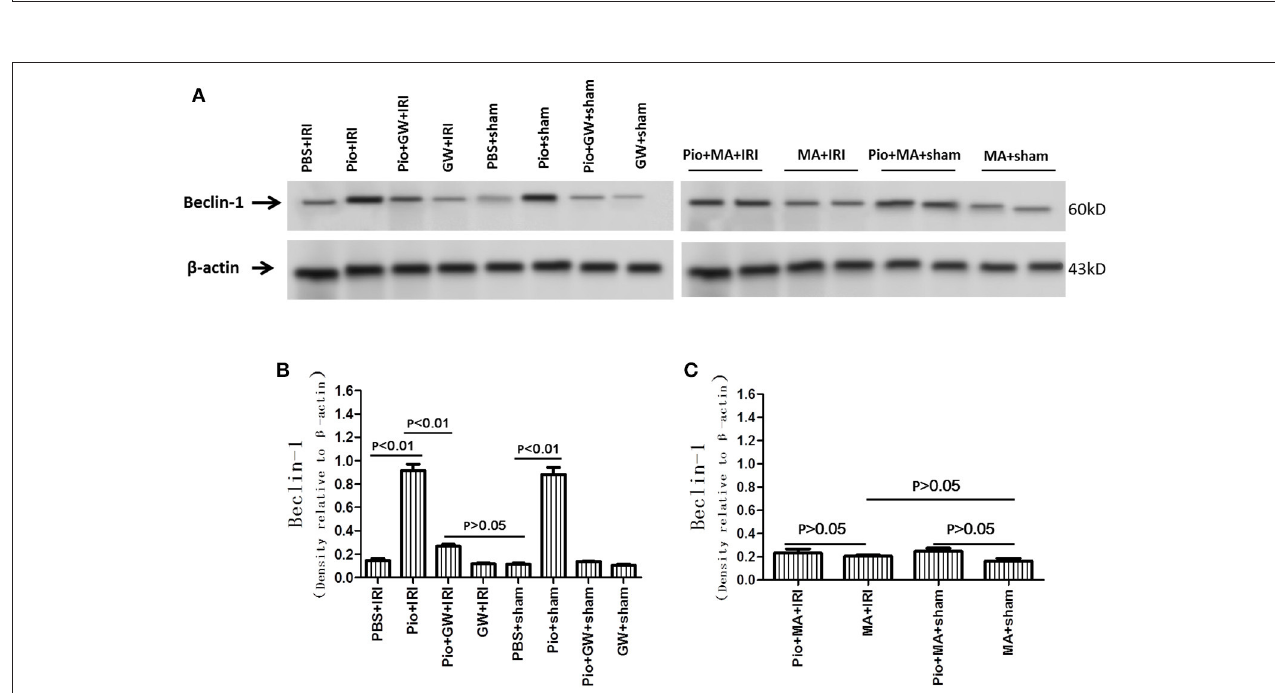
FIGURE 8 | Pioglitazone increases Beclin-1 protein at 24h after renal IRI. (A) Representative western blots show Beclin-1 protein level in the kidneys. (B,C) Quantitative analysis of Beclin-1 protein level in the kidneys. Values are expressed as means ± SE (B,C) . n = 6 in each group.